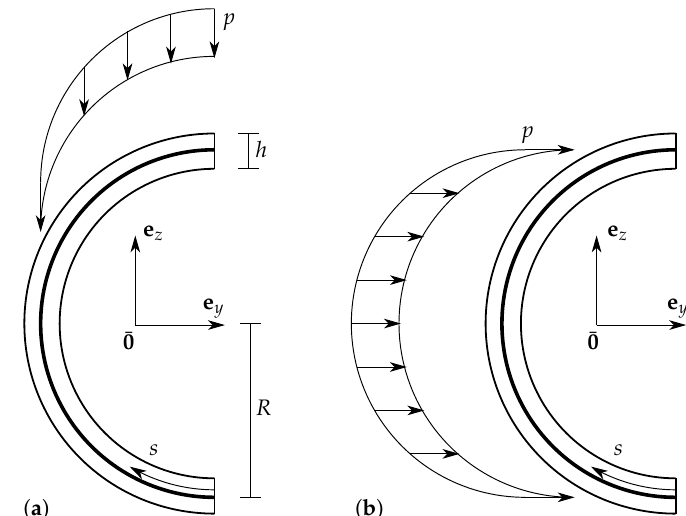
Figure 3. Cross-section and load conditions in case-studies: ( a ) load condition 1; ( b ) load condition